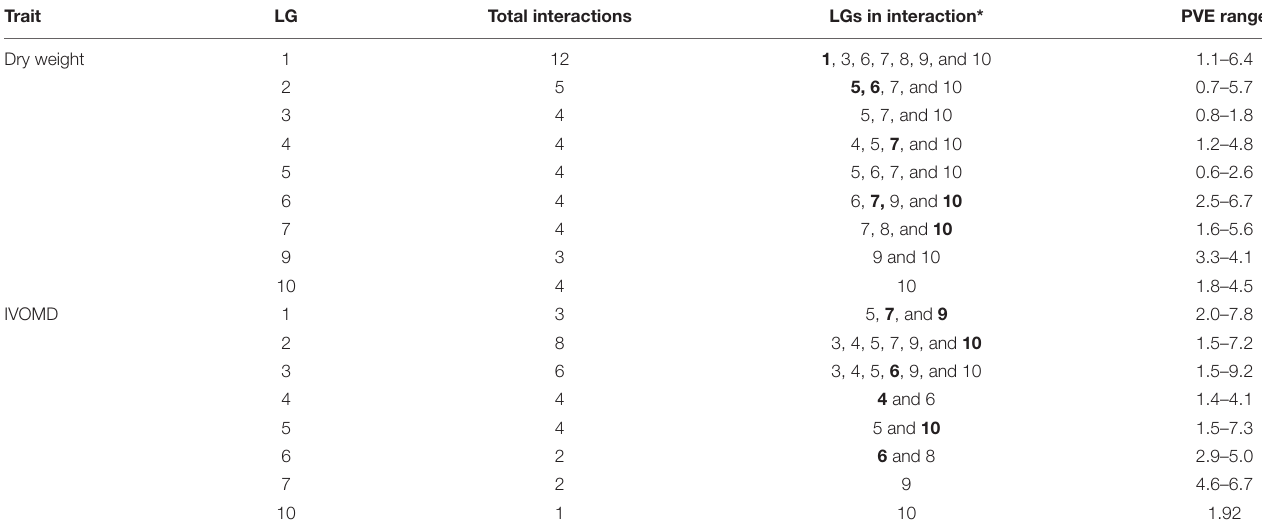
TABLE 6 | Epistatic interactions for dry weight and the digestibility trait in ICSV1 × ICSV700 RIL